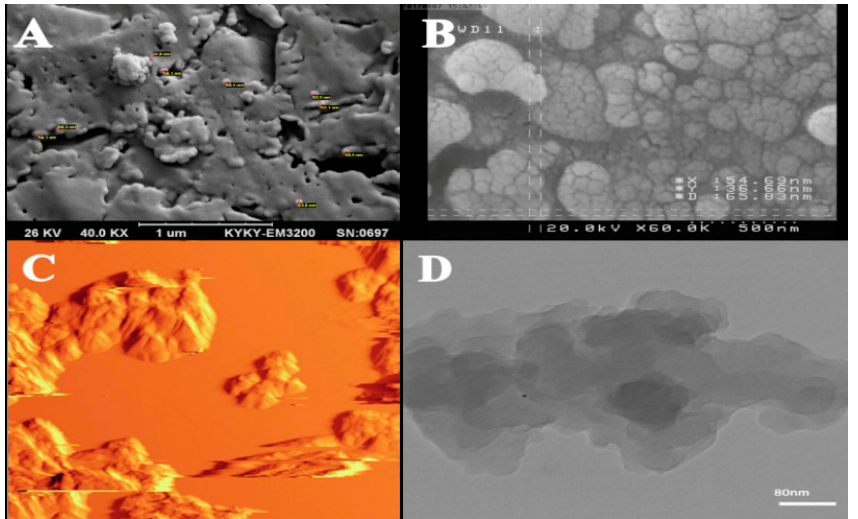
Figure 1. ( A ) SEM image of silver nanoparticle in LPDE polymer (Magnification X60), ( B ) FESEM image of coagulated copper nanoparticles (Magnification X60), ( C ) AFM image of silver nanoparticles (Scale of 80 nm), and ( D ) TEM image of silver